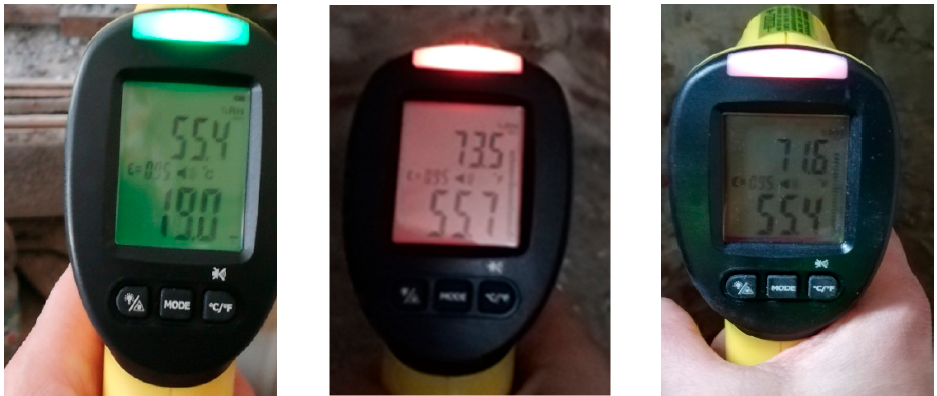
Figure 1. Examples of air humidity and air temperature tests using a pyrometer and a dew point